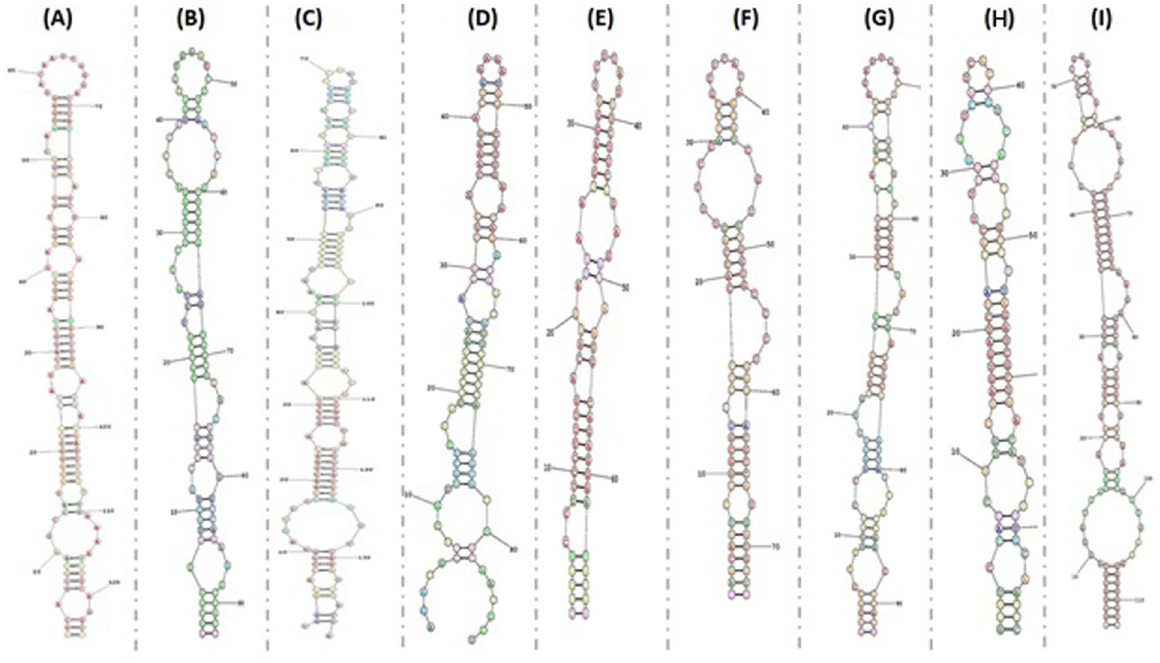
Fig 2. Minimum free-energy (MFE) value in RNAstructure webserver and the MFE secondary structure and positional entropy of 9 real pre- miRNAs were created. (A) MD96; (B) MR124; (C) MR46; (D) MD105; (E) MD76 (F)MR90 (G) MD94 (H) MR64 (I) MD101.